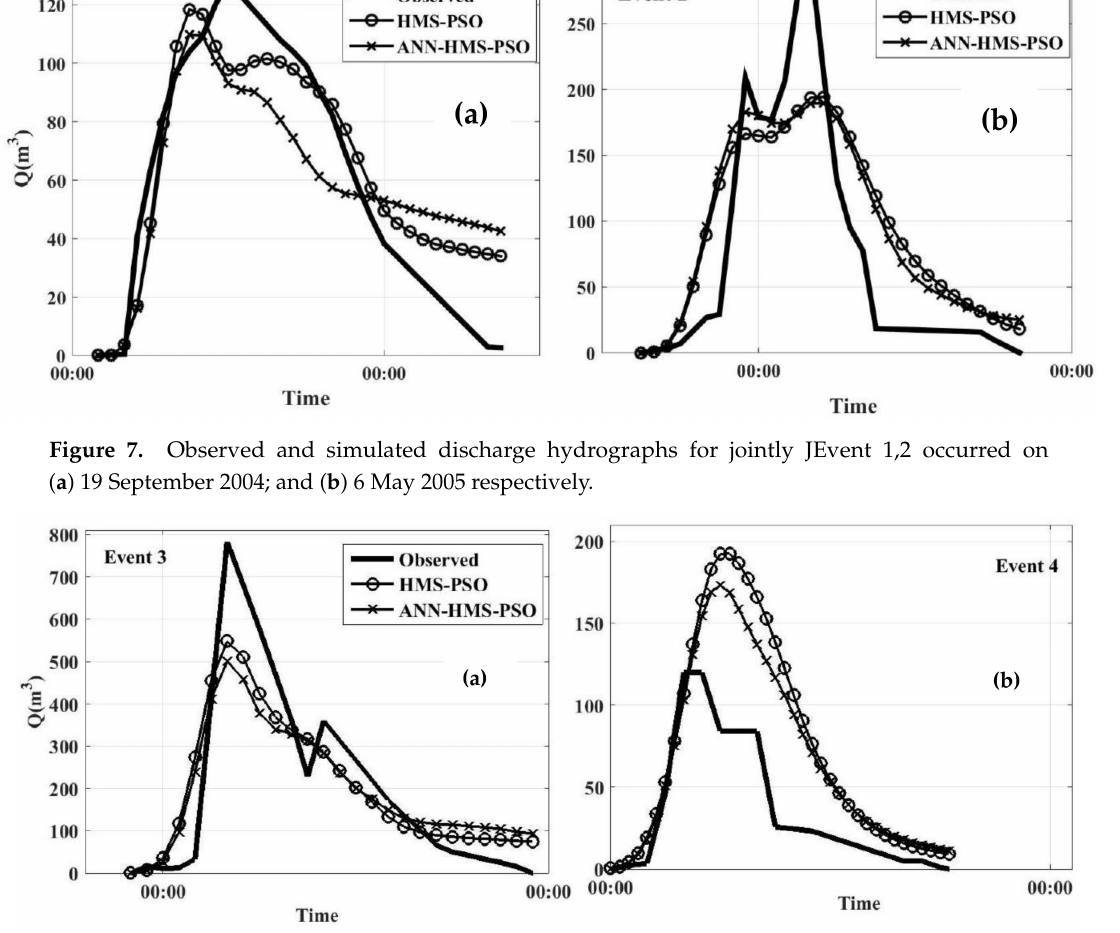
Figure 8. Observed and simulated discharge hydrographs for jointly JEvent 3,4 occurred on ( a ) 9 August 2005; and ( b ) 8 October 2005 respectively.